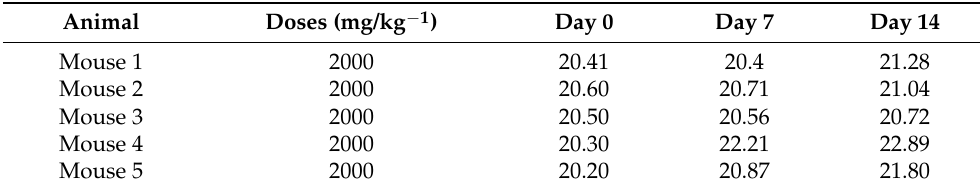
Table 3. Weight (g) of the animals orally exposed to the